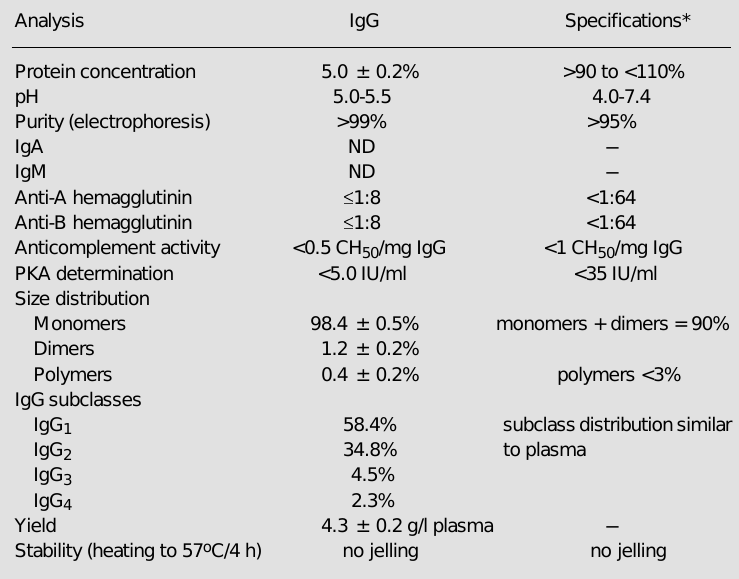
Table 1 - Characteristics of an IgG solution suitable for intravenous administration. N = 28. ND = Not detected. *European Pharmacopoeia (10) and regulation of the Brazilian Health Ministry – Portaria No. 2 (11).